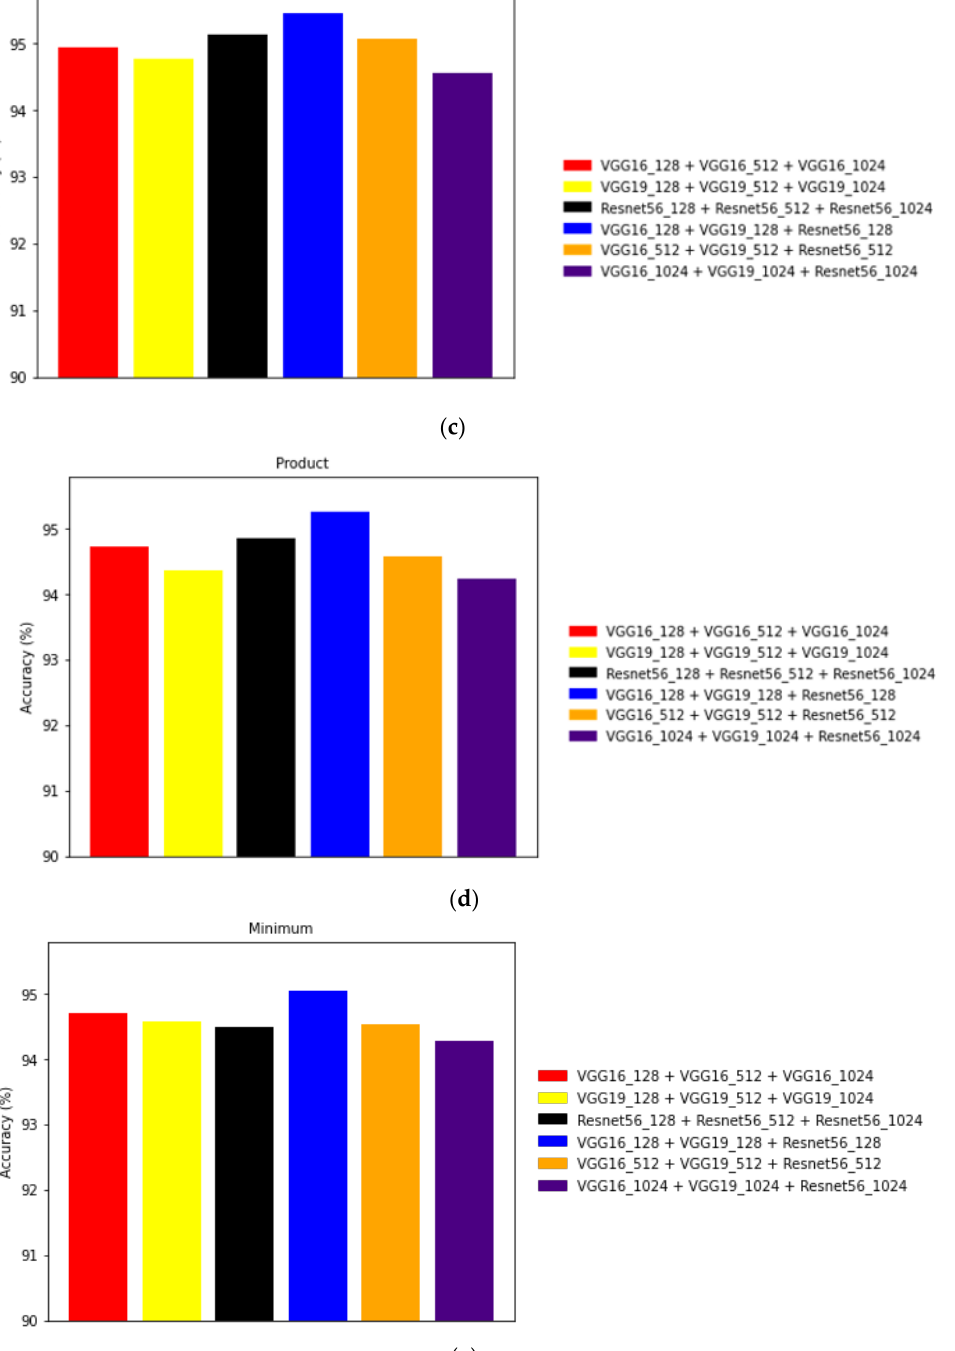
Table 5. Comparison with the baseline models.